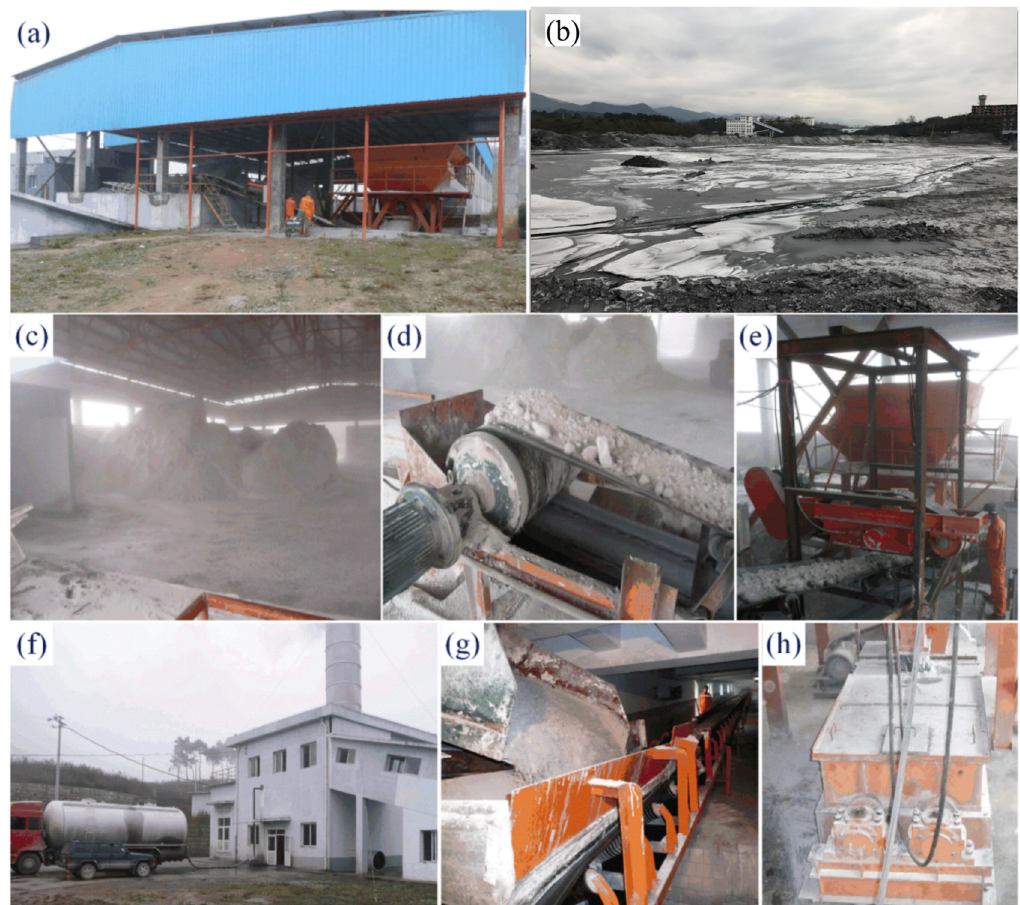
Figure 6. (Source: Kai-lin Group Co., LTD, Guiyang, China) Configuration diagram of the Kai-lin Mine Backfill system in the mining industry: ( a ) panorama of backfill station; ( b ) phosphogypsum storage yard(outside); ( c ) phosphogypsum storage yard(inside); ( d ) phosphogypsum conveyor; ( e ) stable hopper; ( f ) cement silos; ( g ) belt conveyors; and ( h ) horizontal double-shaft mixer.